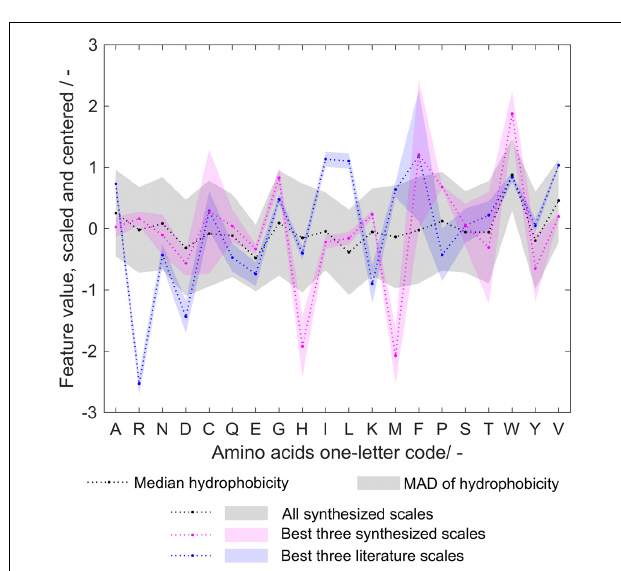
FIGURE 9 | Median and median absolute deviation (MAD) of amino acid hydrophobicity for all synthesized, the three best synthesized, and the three best literature scales. The hydrophobicity scales are centered and scaled to unit variance. For comparison purposes, the sign of hydrophobicity scales was changed so that tryptophan (W) hydrophobicity was always positive. Amino acids are represented with one-letter code. The MAD is visualized by a shaded